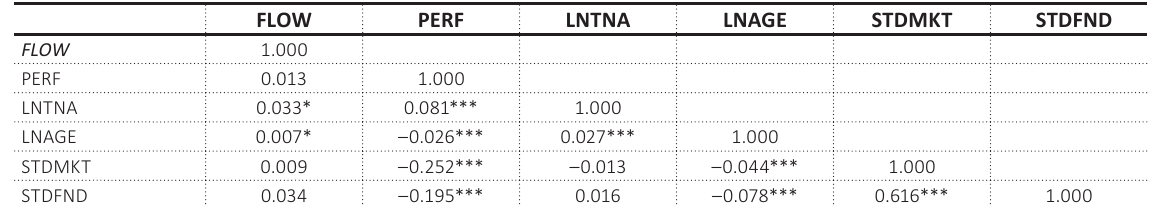
Source: Authors’ estimations